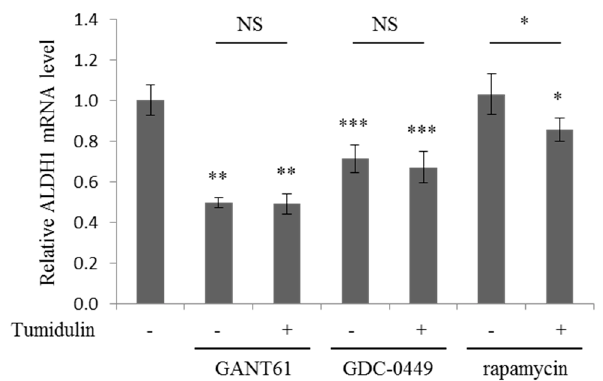
Figure 6. Effects of tumidulin on mRNA expression levels of ALDH1 in the presence of Gli, SMO, and mTOR inhibitors. CSC221 cells were treated with 5 µg/mL GANT61 (Gli inhibitor), GDC-0449 (SMO inhibitor), and rapamycin (mTOR inhibitor) together with or without 12.5 µM tumidulin for 48 h. Quantitative analysis of mRNA expression level of ALDH1 were presented as mean ± SEM, ( n = 3). Analysis was performed by one-way ANOVA. * p < 0.05; ** p < 0.01; *** p < 0.001; NS: no significant difference compared with DMSO-treated CSC221 cells or between indicated groups.